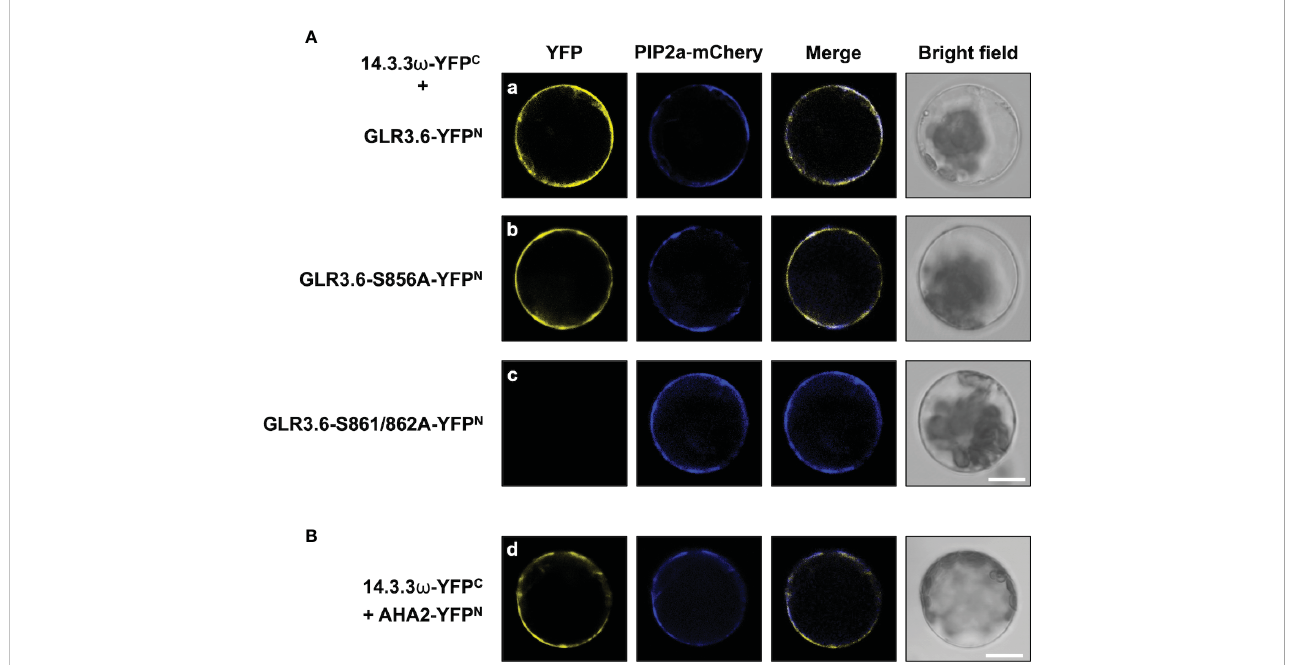
FIGURE 5 GLR3.6 interaction with 14-3-3 w in the plasma membrane was analyzed in Arabidopsis cells. BiFC assay was used to analyze the protein – protein interaction. Confocal microscopy was used to detect the reconstitute YFP fl uorescence signal. (A) 14-3-3 w -YFP C was co-expressed with (a) GLR3.6- YFP N , (b) GLR3.6-S856A-YFP N , or (c) GLR3.6-S861/862A-YFP N in Arabidopsis protoplast cells. (B) The interaction between (d) AHA2-YFP N with 14-3-3 w - YFP C was used as positive control. Scale bars = 20 m